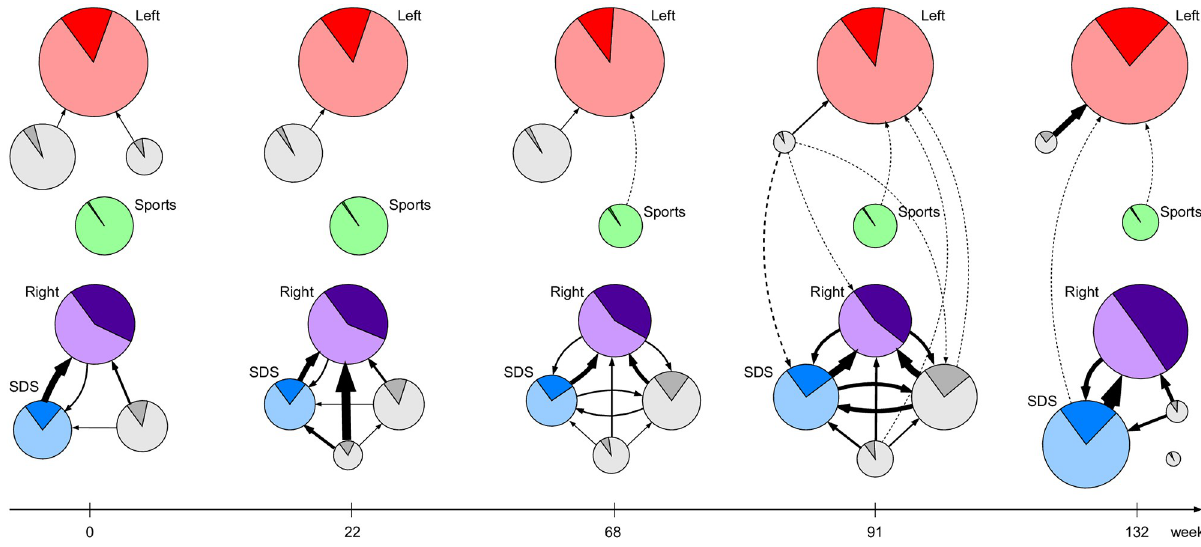
Fig 2. Fractions of unacceptable tweets posted by different communities. Nodes are the largest detected communities at timepoints t = 0, 22, ... , 132. The node size indicates the community size, darker areas correspond to unacceptable tweets, and lighter areas to acceptable tweets. An edge denotes the external influence of community C to C . Linked communities form super-communities: left-leaning (Left, top), Sports (middle), and right-leaning i j (Right and SDS, bottom).